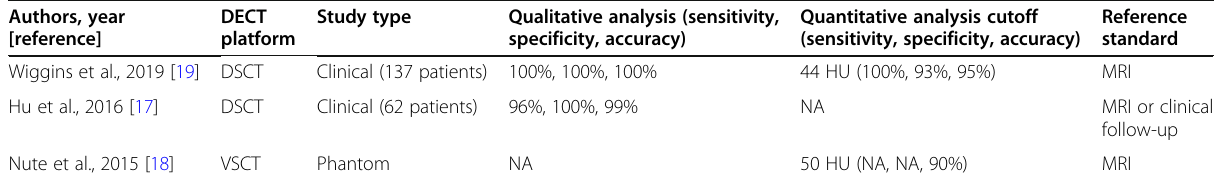
Table 1 Virtual non-calcium computed tomography (CT) ability to differentiate hemorrhage from parenchymal calcifications on dual-energy head scans